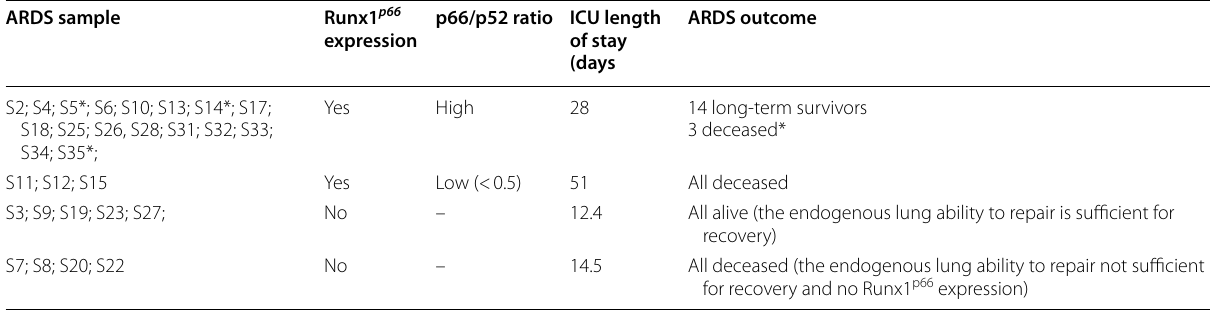
29 EV ARDS preparations and 3 EV Ctrl were lysed and subjected to WB analyses with Runx1 Ab. Runx1 immunoreactivity was quantified by densitometry (NIH ImageJ) and used to establish the Runx1p66/p52 ratio. EV ARDS samples S5*, S14* and S35* illustrate special situations of three ARDS patients that died despite their high Runx1p66/p52 ratio due to other complications (S5) or removal of life support at family’s request (S14, S35)